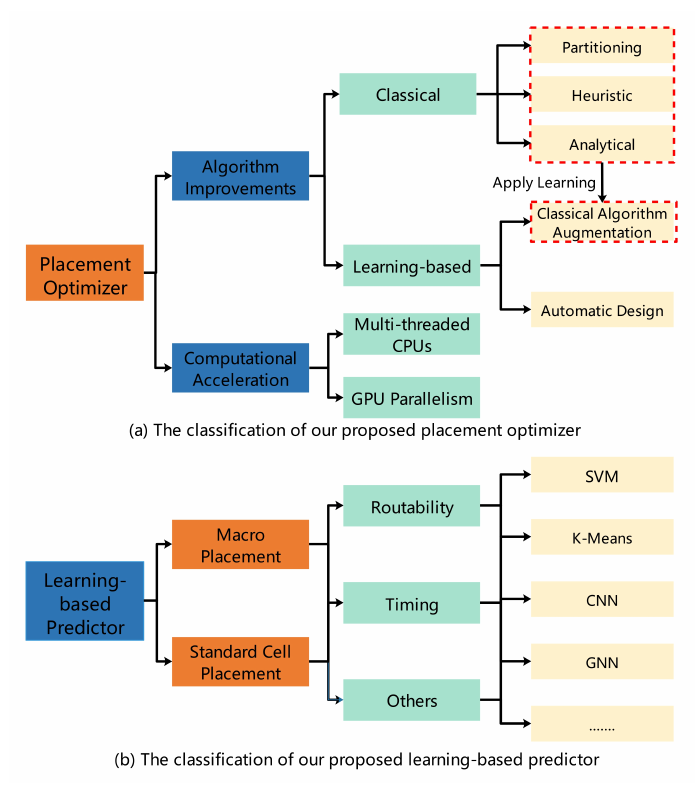
Figure 3. The classification of the placement optimizers and learning-based predictors. The optimizers perform online placement optimization and the predictors perform offline placement